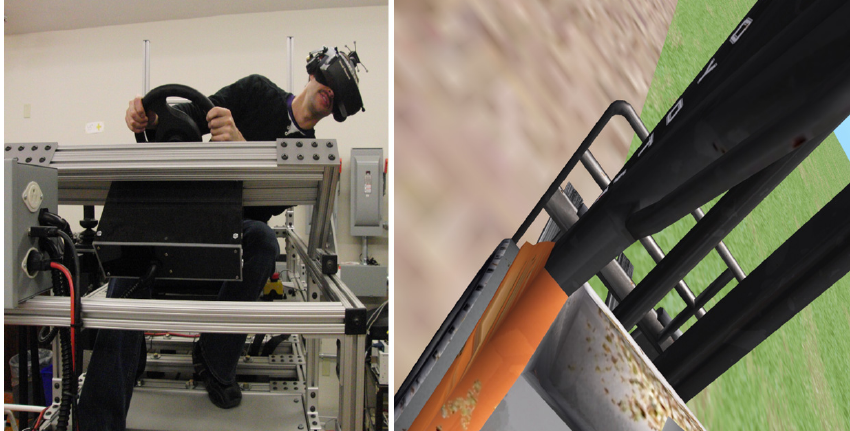
Figure 5. This image shows the subject’s head position and the corresponding visual field. The left image shows the subject leaning to their left so they can get an unobstructed view of the ends of the forks. Note the four marker rigid body (cross) that is attached to the top of the head mounted display to measure the subject’s head position. The right image is the corresponding field of view showing the lift truck structures within the field of view as well as the tips of the forks. The subject needs to adopt this awkward posture in order to visualize the ends of the